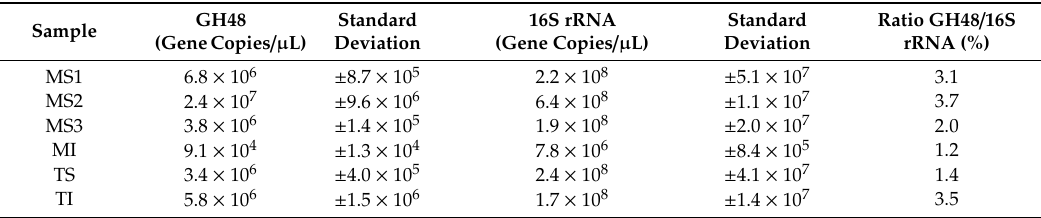
Table 4. GH48 and 16S rRNA gene copy numbers quantified in DNA isolated from in sacco samples of biogas